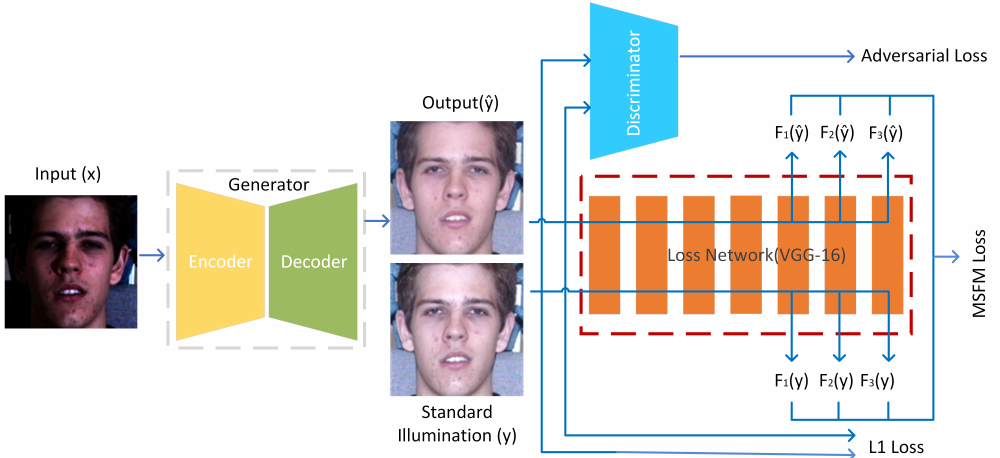
Figure 2. Our overall network framework. The core of our method mainly contains 3 parts: an elaborately designed generator, a discriminator and a loss